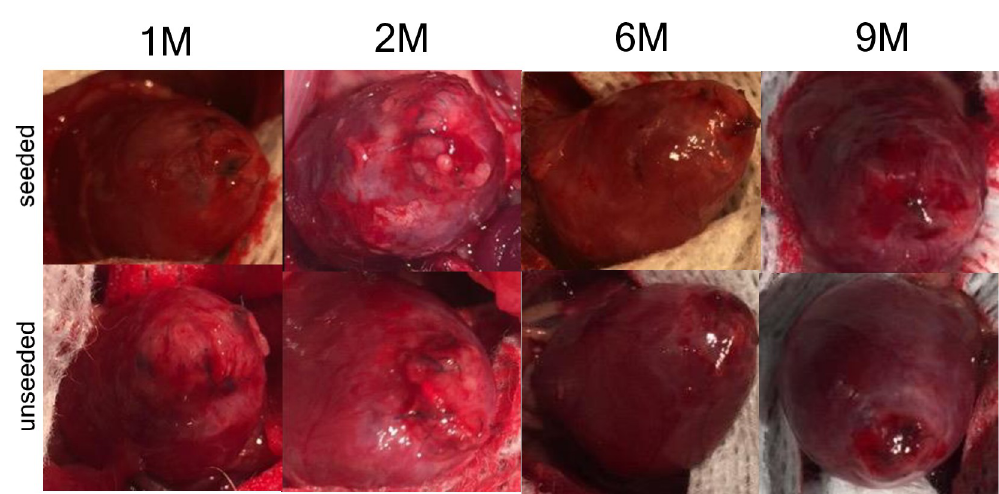
Fig 3. Macroscopic view of operated rat hearts. Over time, some fibrous adhesions on the pericardial surface formed. The patch was sutured in the heart interior. There were no significant differences in macroscopic findings between the two groups.